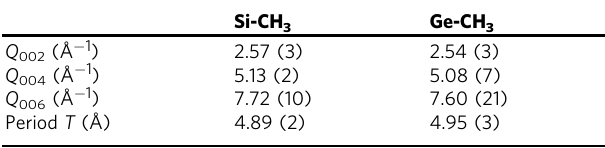
Table 1 Positions of in fl exion points of 00 l sawtooth peaks from powder WAXS diagrams of Si(Ge)CH 3